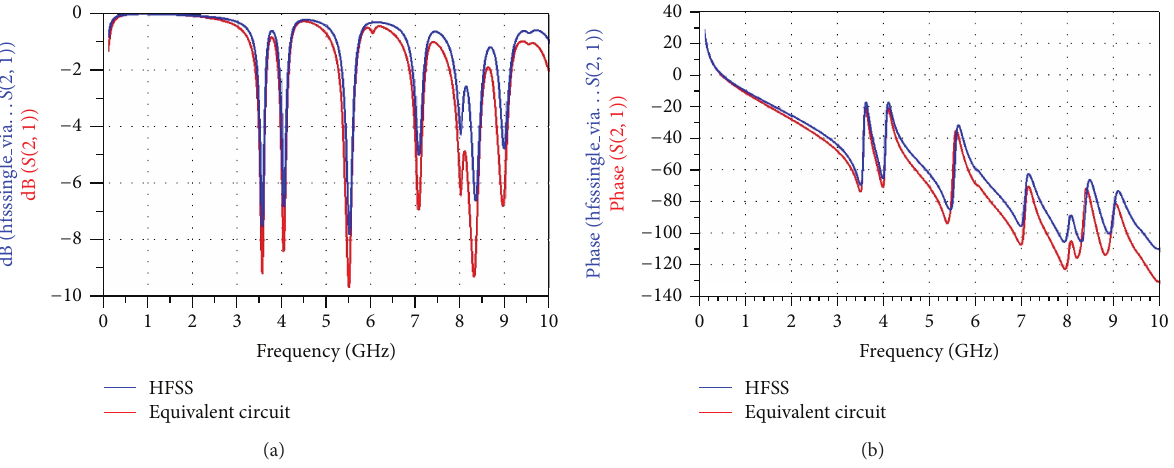
Figure 19: 𝑆 21 of single via structure in multilayer: (a) amplitude; (b) phase.